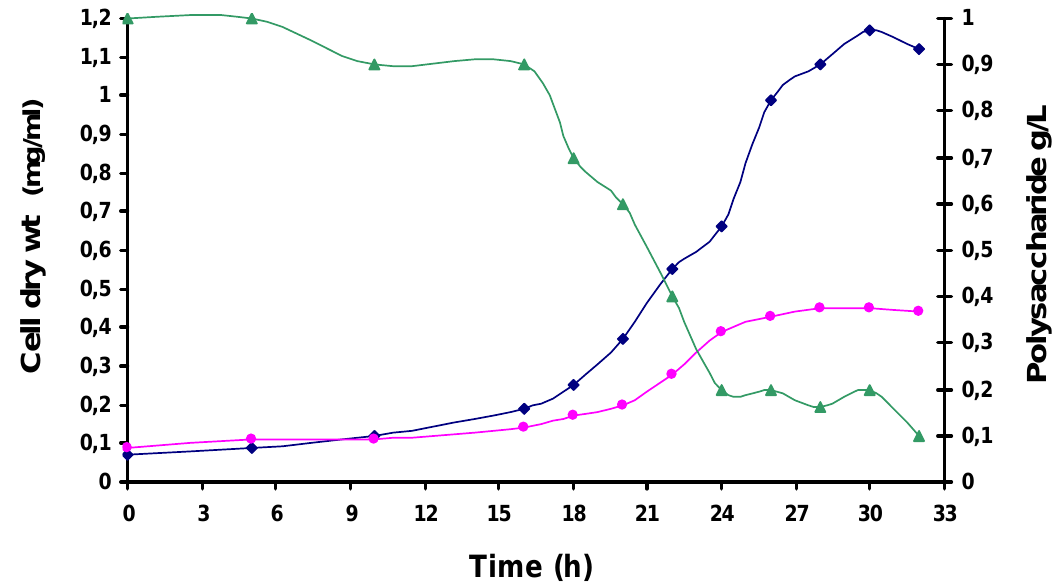
Figure 5 . Biodegradability test of Sample A using thermohalophilic Thermus thermophilus